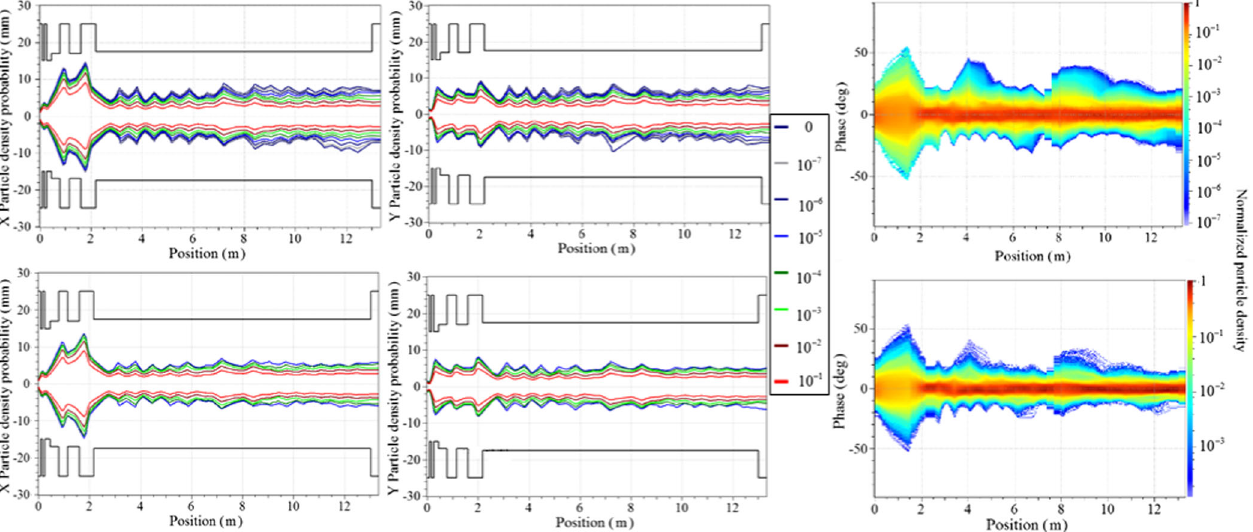
FIG. 19. The transverse particle density (graphs on the left and in the middle) and longitudinal power density (right graph) with errors, corrections (upper) and without errors (lower).